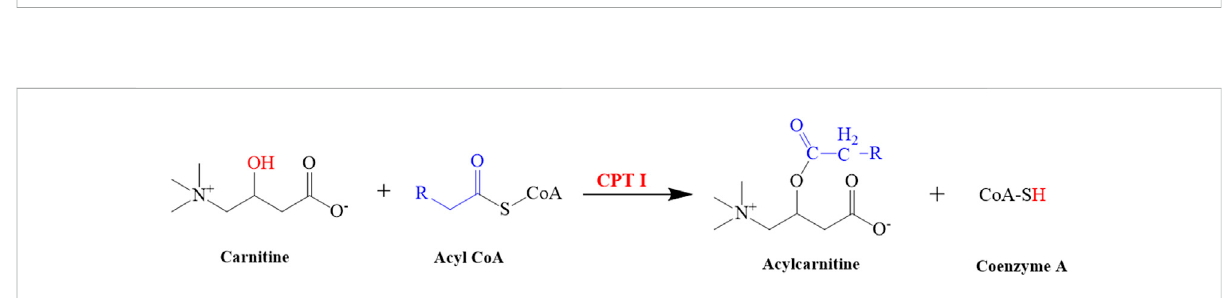
FIGURE 9 Illustrated the conversion of carnitine into acylcarnitine. This reaction is catalyzed by CPT